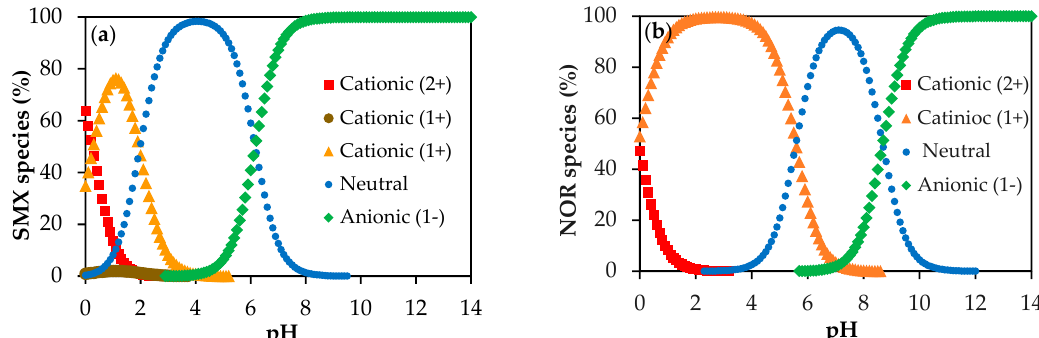
Figure 1. Speciation of SMX ( a ) and NOR ( b ) as a function of pH, prediction calculated data from Chemicalize software [31].